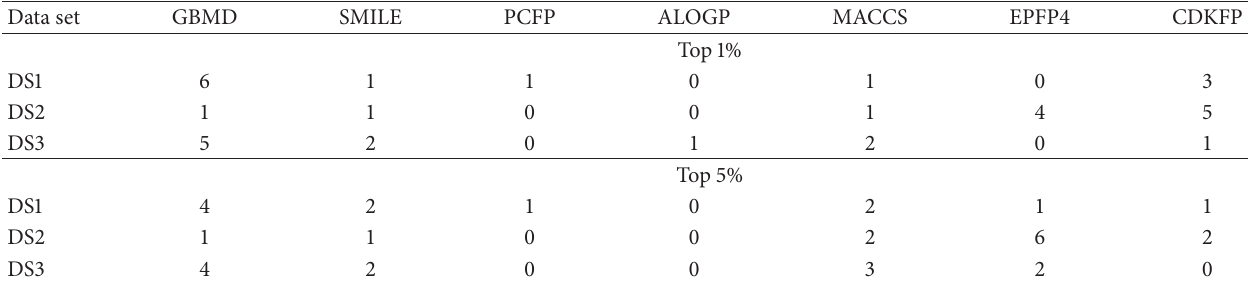
Table 11: Numbers of bold cells for mean recall of actives using different descriptors: DS1-DS3 Top 1% and 5%.